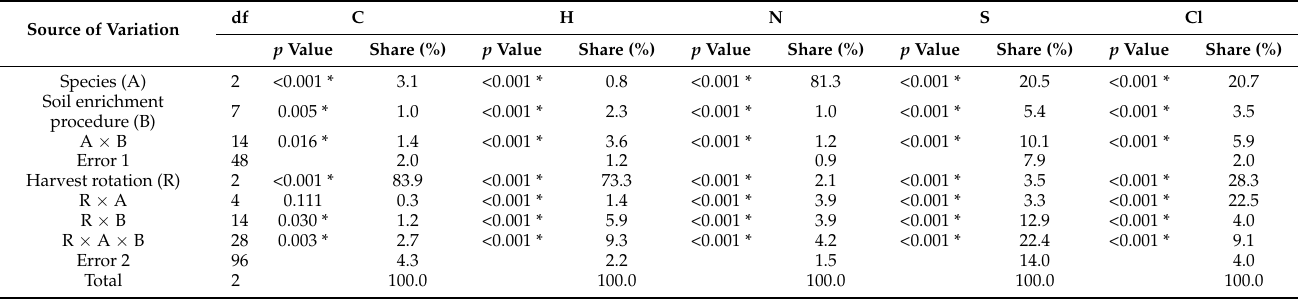
Table 3. Statistics of p values from the repeated measurement variance analysis and the percentage of the effects in the overall variance for the SRWC biomass elemental